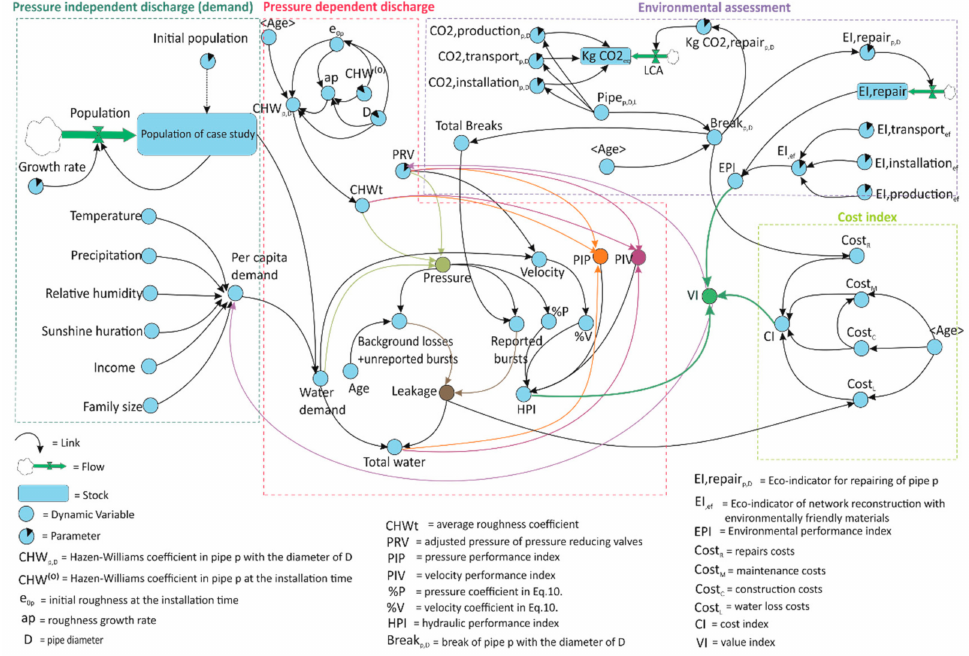
Figure 2. System Dynamics (SD) framework in Anylogic